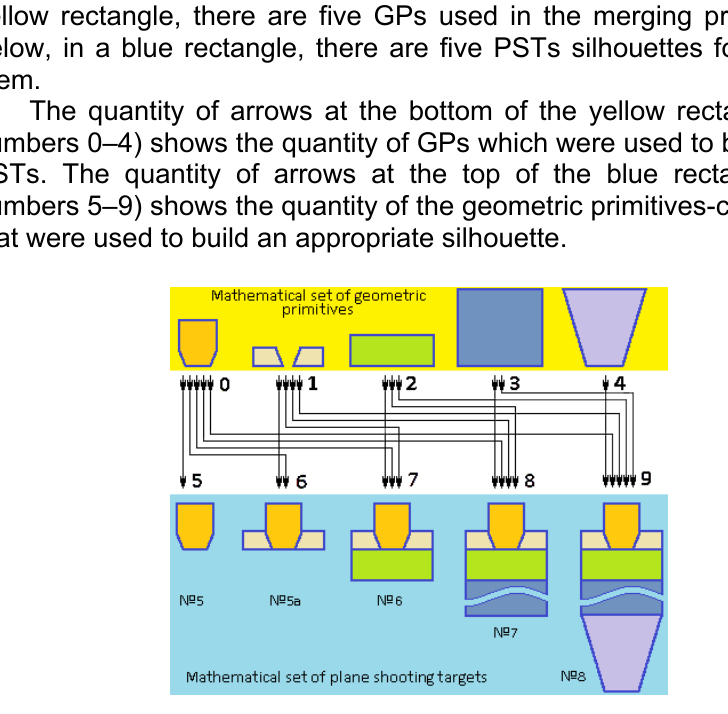
Figure 3 – The implementation of the principle of consistently combining geometric primitives into target silhouettes (the shooting targets design system) Рис . 3 – Реализация принципа последовательного объединения геометрических примитивов в силуэты стрелковых мишеней ( система порождения мишеней